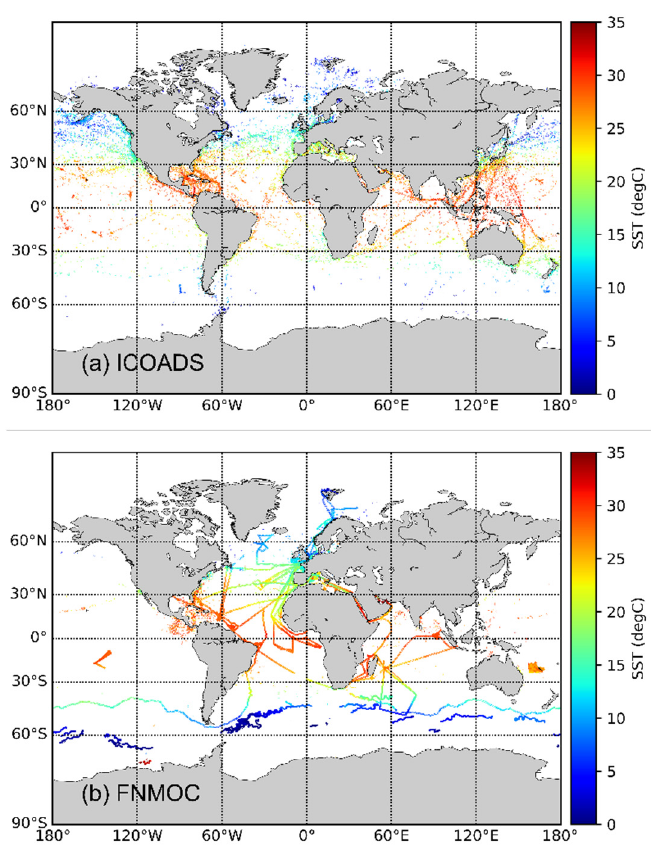
Figure 4. The trajectories of the ships with UIDs found only in ( a ) ICOADS and ( b ) FNMOC. (Note that both exclude ‘stationary’ ones). The color bar represents the SST.